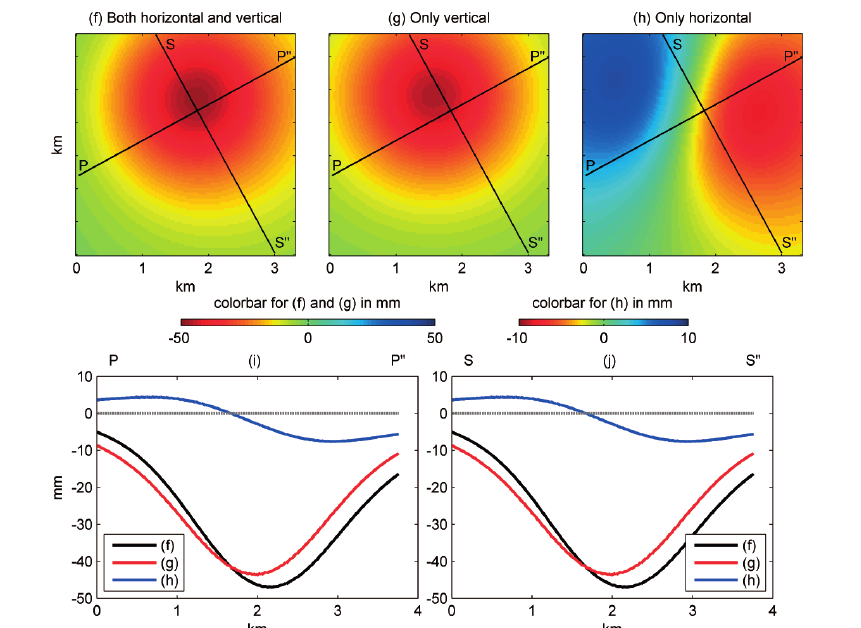
Figure 9. ( a ) InSAR derived line of sight cumulative displacement field in Gudao Town between Feb 7, 2007 and Jan 21, 2010 using the mean value as InSAR reference. ( b ) Best approximated displacement field using a disk reservoir model. ( c ) Residuals between InSAR and modeled displacements. ( d ) Profile P-P” through the data (triangle), the model (line), and the residuals (crosses). ( e ) Same for the profile S-S”. ( f ) Modeled vertical and horizontal displacement seen from radar LOS direction. ( g ) Modeled vertical displacement seen from radar LOS direction. ( h ) Modeled horizontal displacement seen from radar LOS direction. ( i ) Profile P-P” through both vertical and horizontal (black), only vertical (red), and only horizontal (blue) displacements. ( j ) Same for the profile